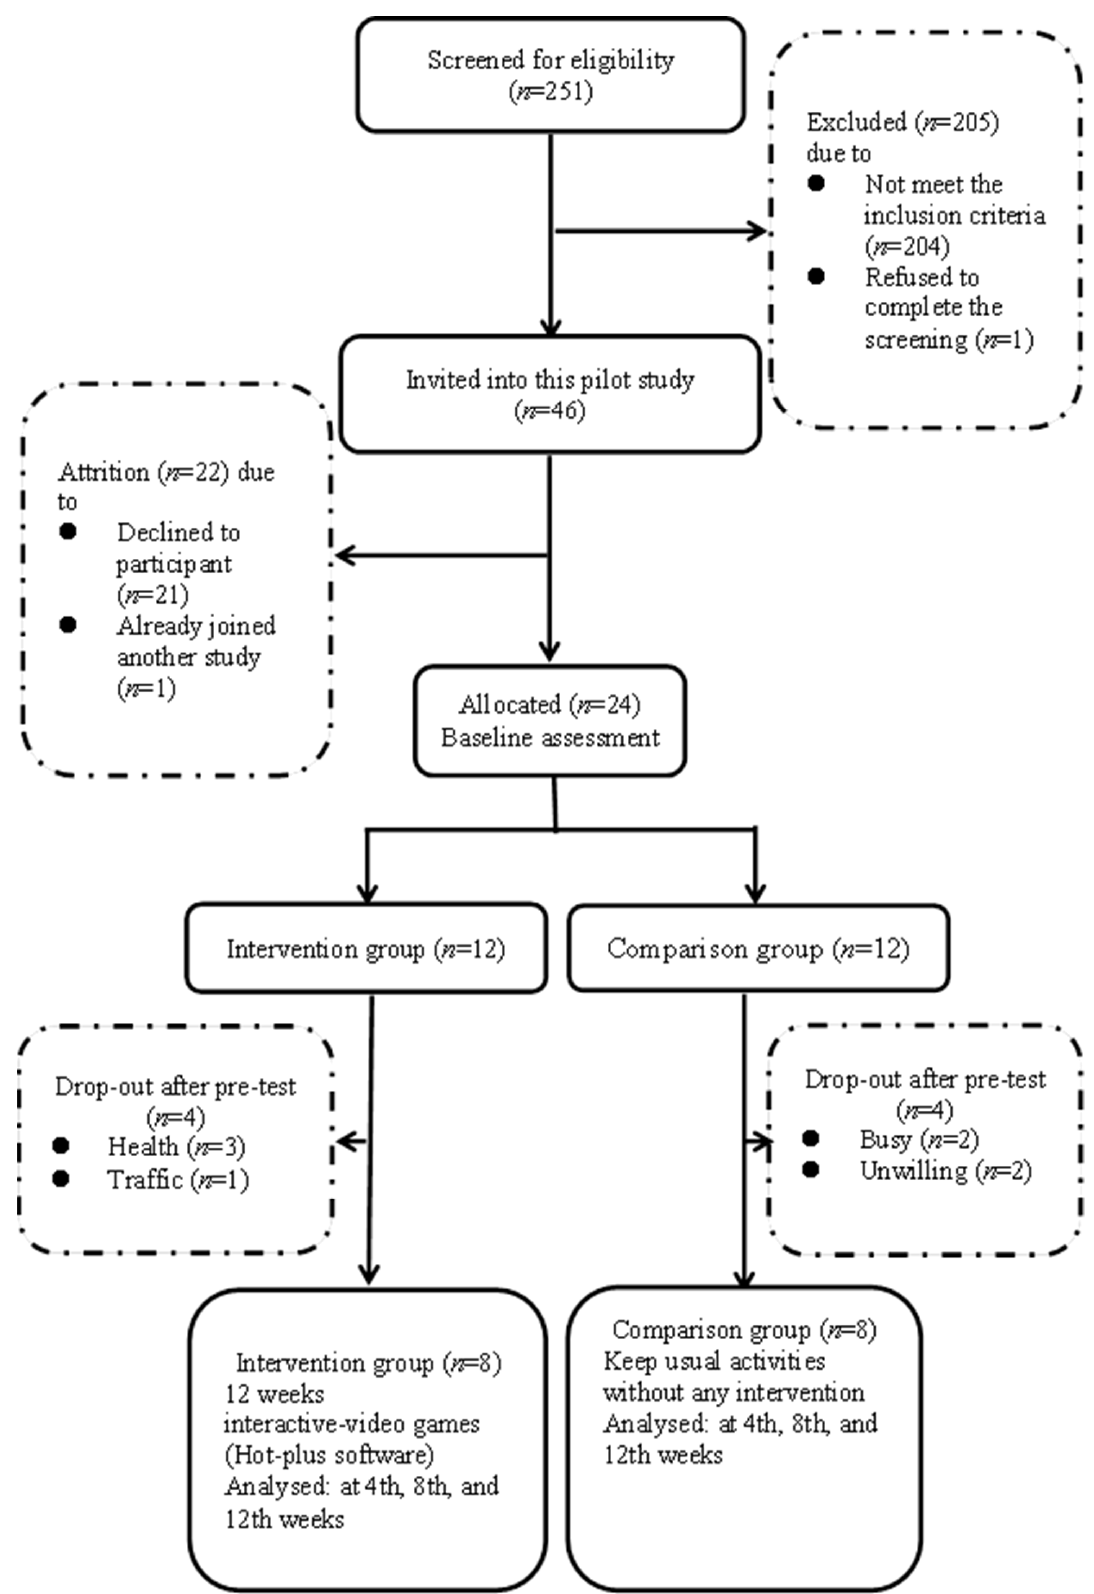
Figure 1. Flow diagram.